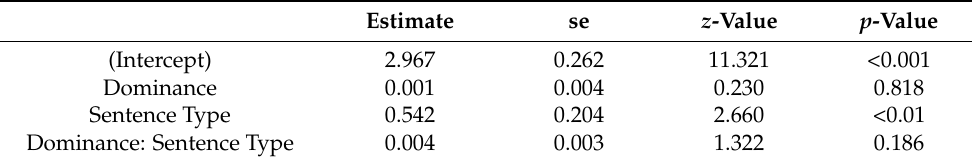
Table 5. Results of the logistic mixed-effects model of offline comprehension